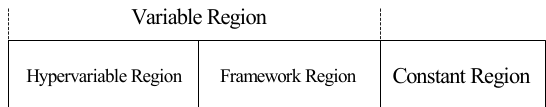
Fig. 2. The biological structure of